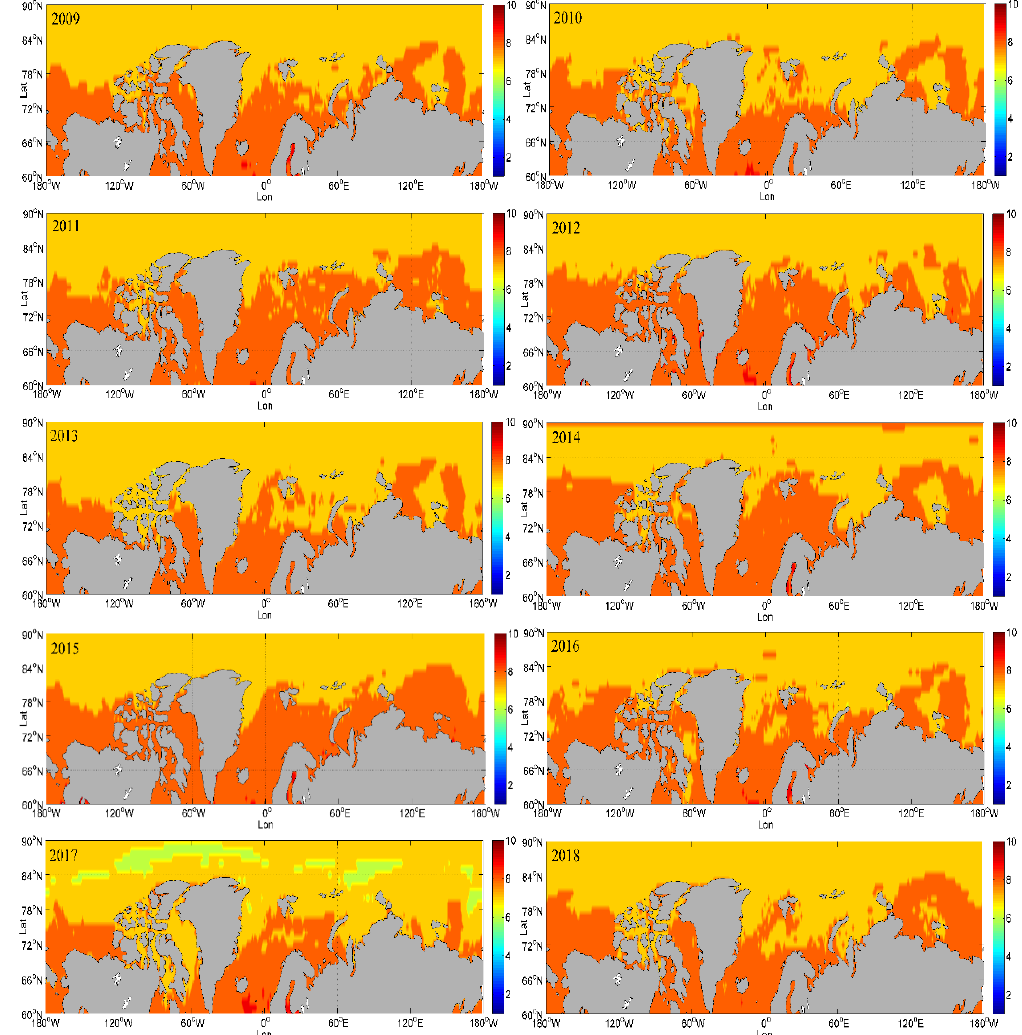
Figure 10. Yearly mean visibility in the Arctic from 2009–2018. Atmosphere 2018 , 9 , x FOR PEER REVIEW